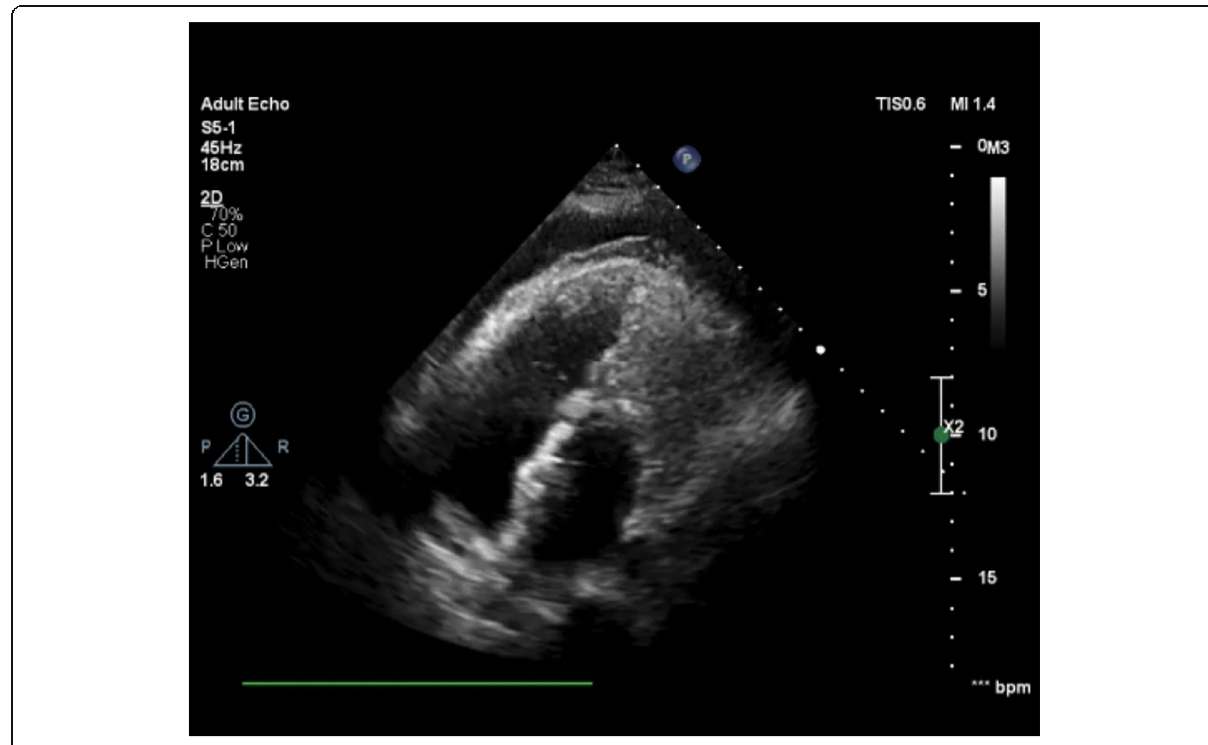
Fig. 2 post TTC of ASD in the first patient TTE revealed moderate to severe PE